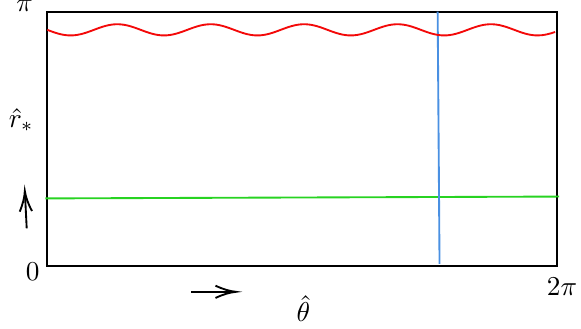
Figure 6 . The coloured horizontal line corresponds to fixed ˆ r ∗ and coloured vertical line corresponds to fixed ˆ θ and the wavy line indicates the singularity where φ = − 1